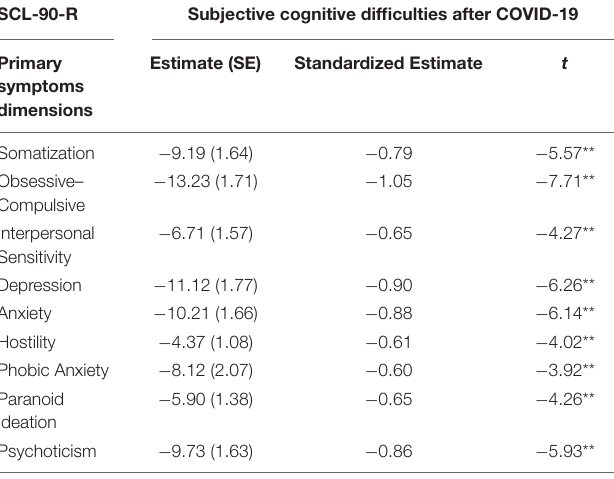
TABLE 2 | Symptoms Checklist-90-R and Cognitive Reserve Index Questionnaire scores. Symptoms Checklist-90-R